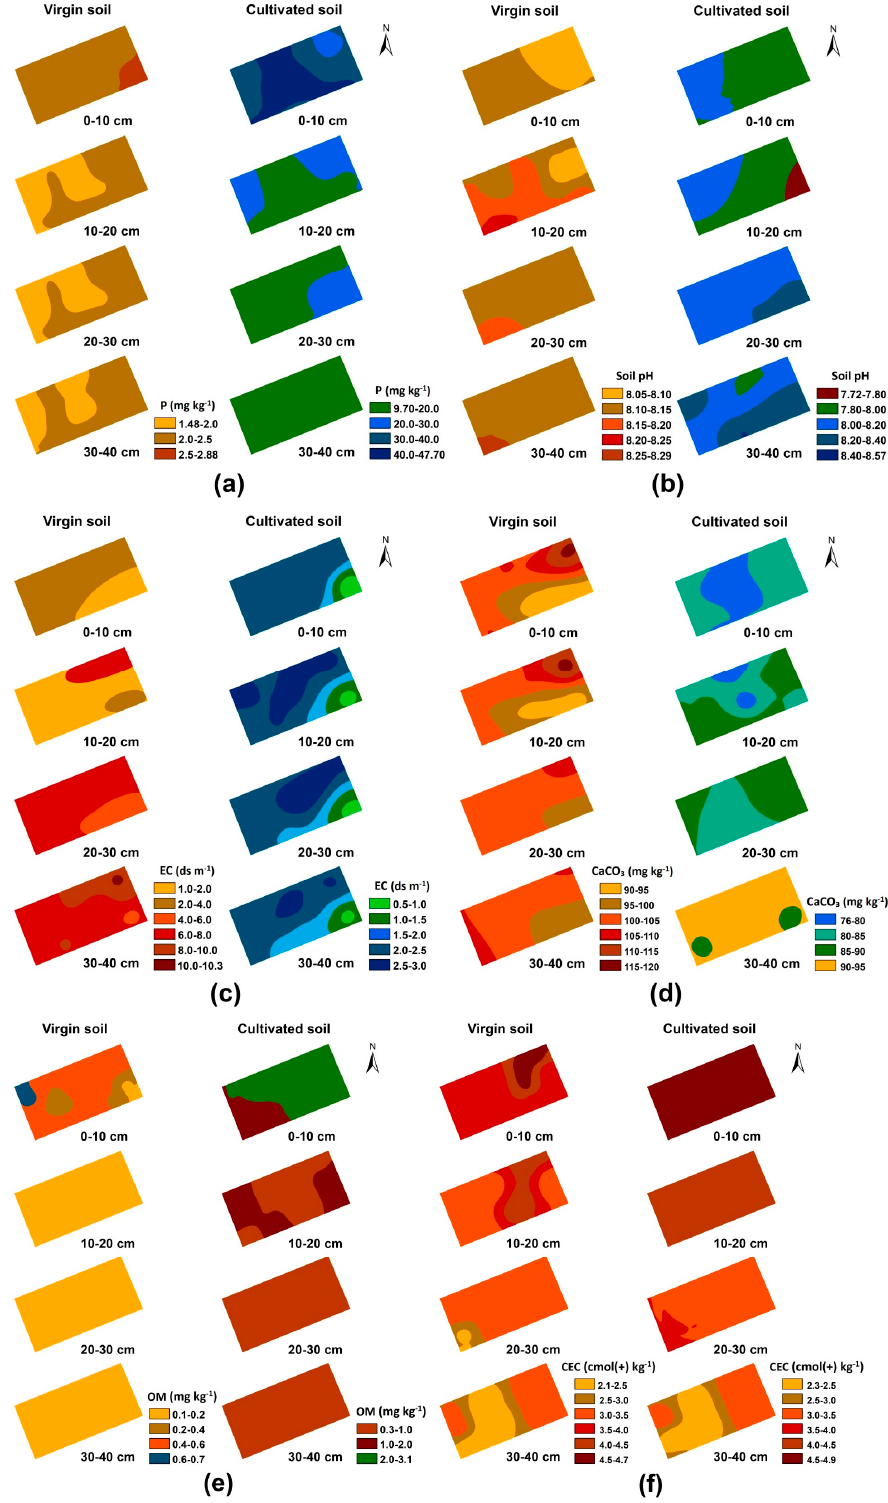
Figure 5. Spatial distribution patterns of virgin and cultivated soil properties at the investigated depths: ( a ) available phosphorus (P); ( b ) soil pH; ( c ) soil electrical conductivity (EC); ( d ) CaCO 3 content; ( e ) organic matter (OM); ( f ) cation exchange capacity (CEC).